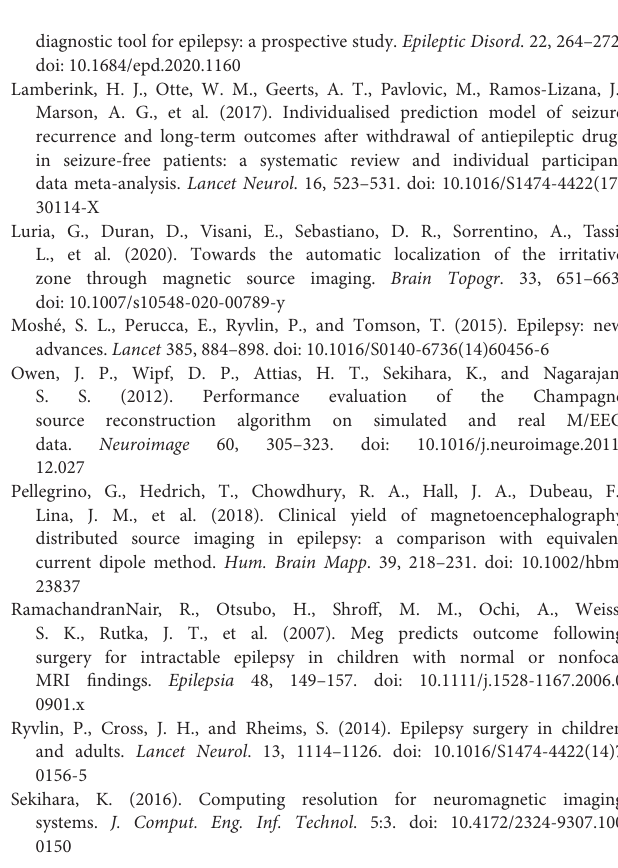
Supplementary Table 1 | Clinical characteristics of the 16 subjects. The first 14 described here appear in Table 1 . Note that some patients were referred from outside institutions and thus their information was limited to that available at the time of the MEG scan. FCD = focal cortical dysplasia; Lt = Left; Rt = Right; temp = temporal; occip - occipital; ATL = anterior temporal lobectomy; MTS = mesial temporal sclerosis; ECoG = electrocorticography; ED = epileptiform discharge; PQ = posterior quadrant; GFPA = generalized paroxysmal fast activity; SEEG = stereo-EEG; hypo = hypometabolism; PVNH = periventricular nodular heterotopia; c/w = consistent